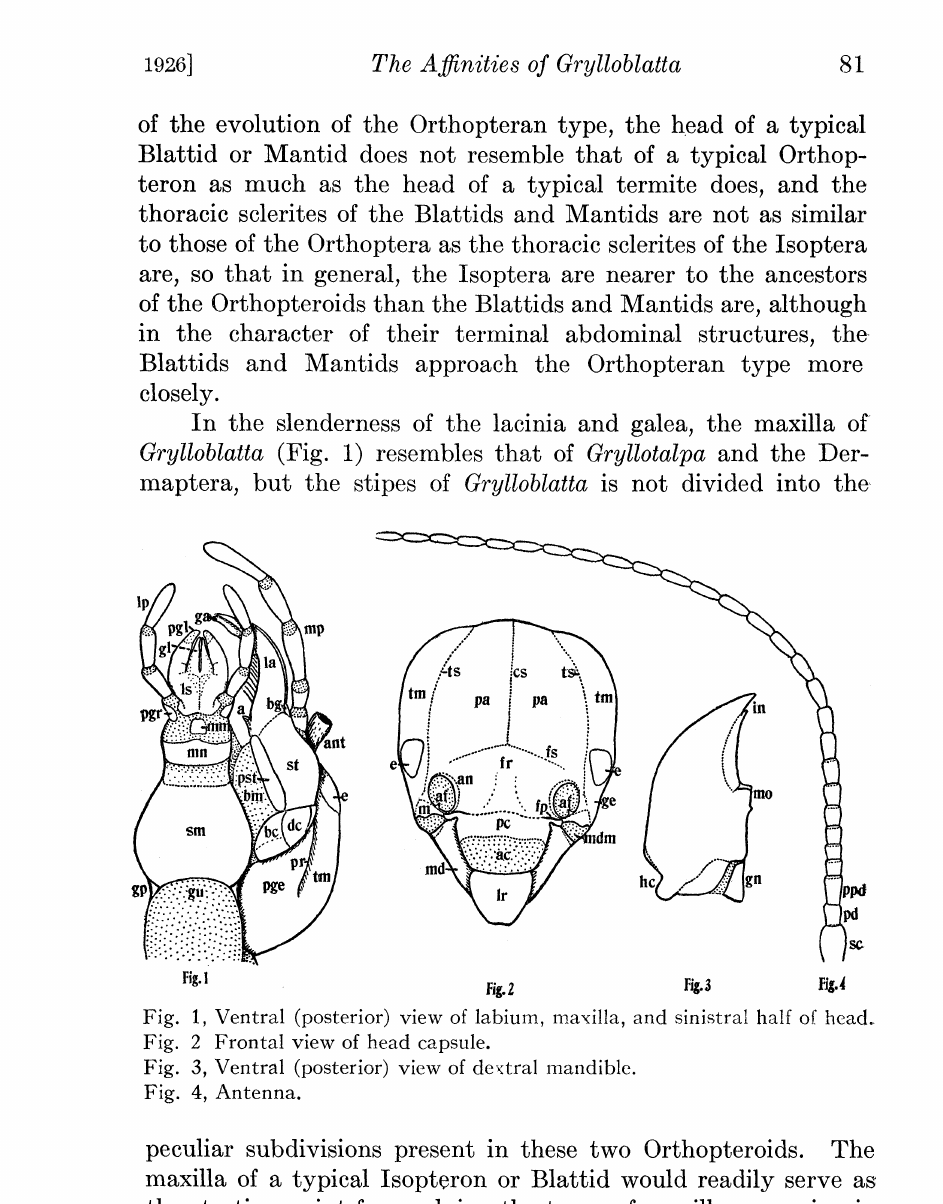
Fig. 1, Ventral (posterior) view of labium, maxilla, and sinistral half of head., Fig. 2 Frontal view of head capsule. Fig. 3, Ventral (posterior) view of dextral mandible. Fig. 4,